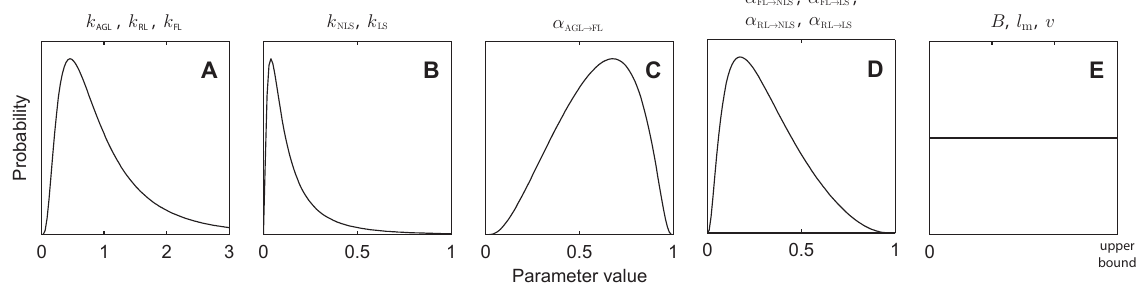
Fig. 3. Prior probability distributions of the model parameters used for calibration setup 3. See Table 2 for the parameters of the distribution functions. All distributions have a lower bound at zero and an upper bound which is given in Table 2.